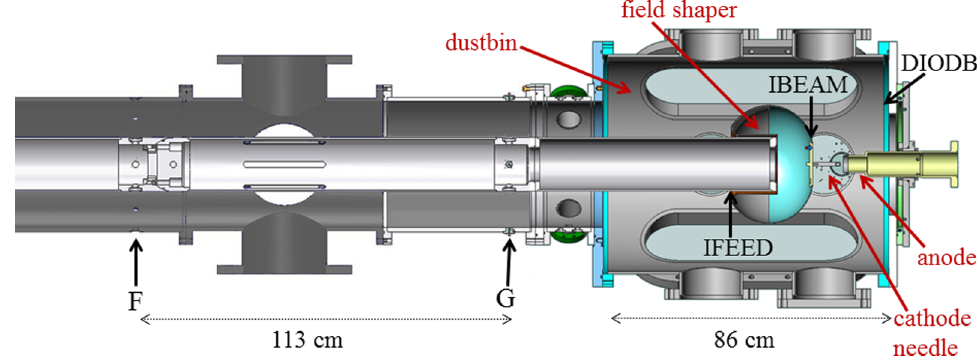
FIG. 1. Diagram of the downstream portion of the RITS-6 accelerator. The B-dot current monitors at positions F, IFEED, IBEAM, and DIODB are labeled.